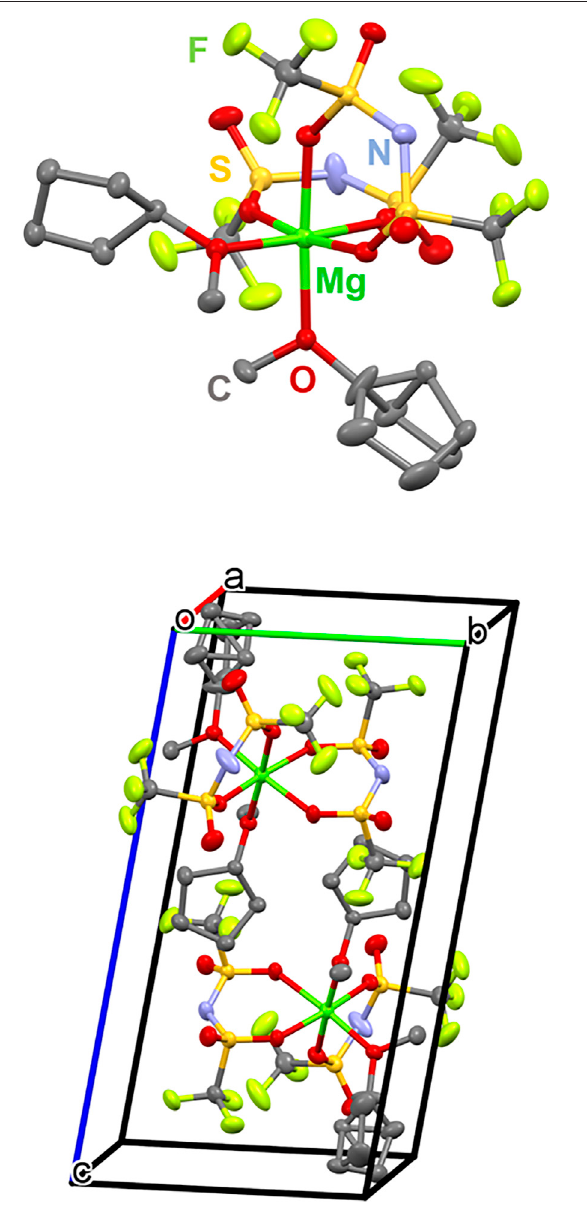
FIGURE 4 | Crystal structure (top) and unit cell structure (bottom) of Mg(TFSA) 2 (CPME) 2 with thermal ellipsoids at the 40% probability level (Mg: green,C:gray,N:paleblue,O:red,F:palegreen,andS:darkyellow.Hatoms are omitted for